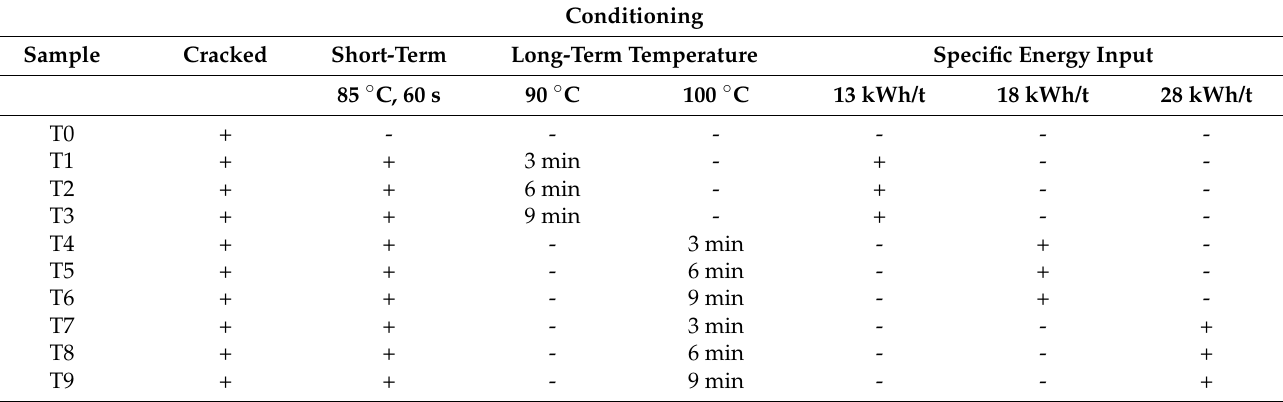
Table 1. Characteristics of heat treatment of full-fat